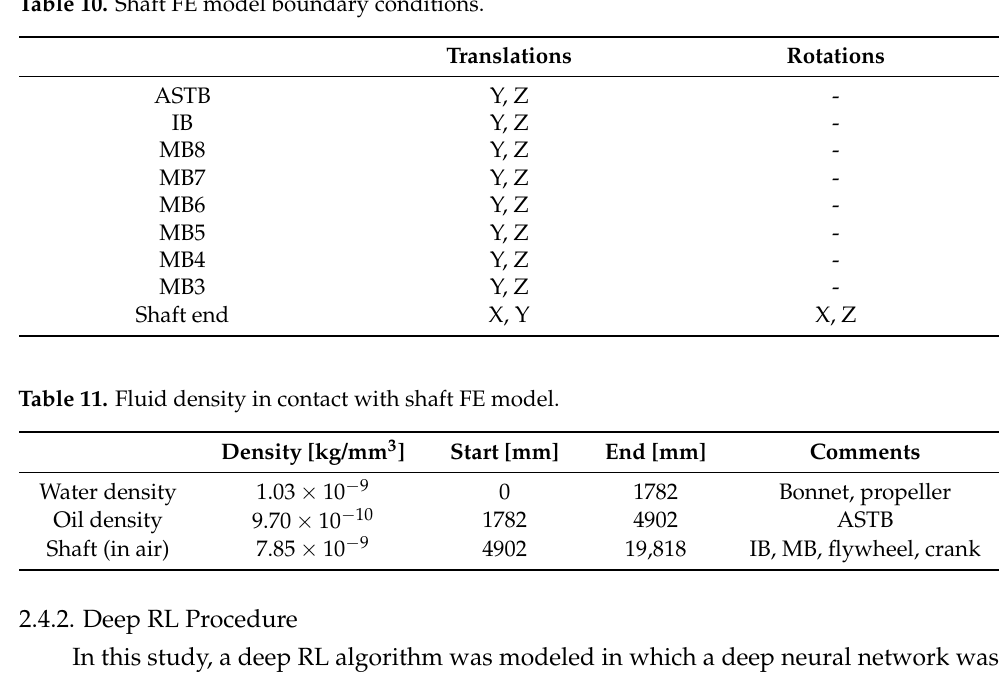
Table 10. Shaft FE model boundary conditions.